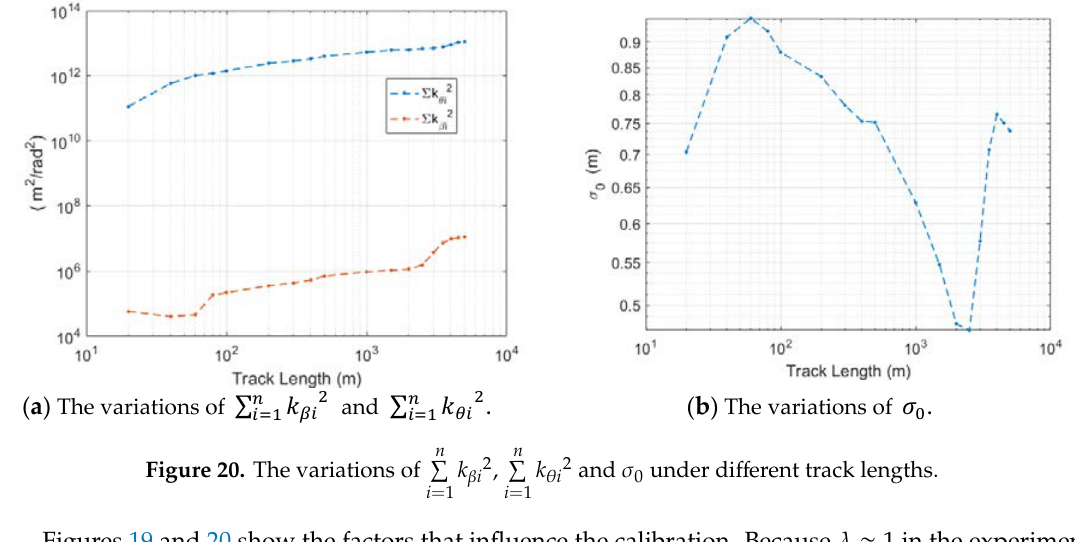
Figure 19. The estimated precision under different track lengths.